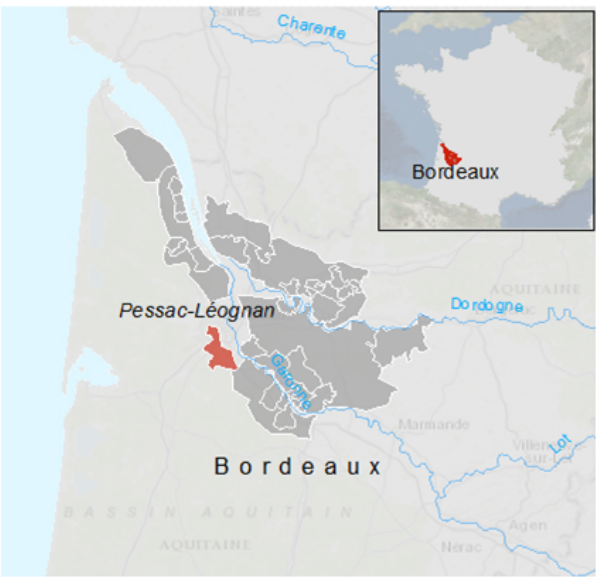
Figure 1. Location of the experimental site in Bordeaux